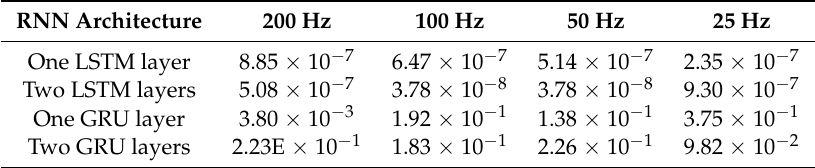
Table 5. L2 error per each model (trained model vs. generated c-model).